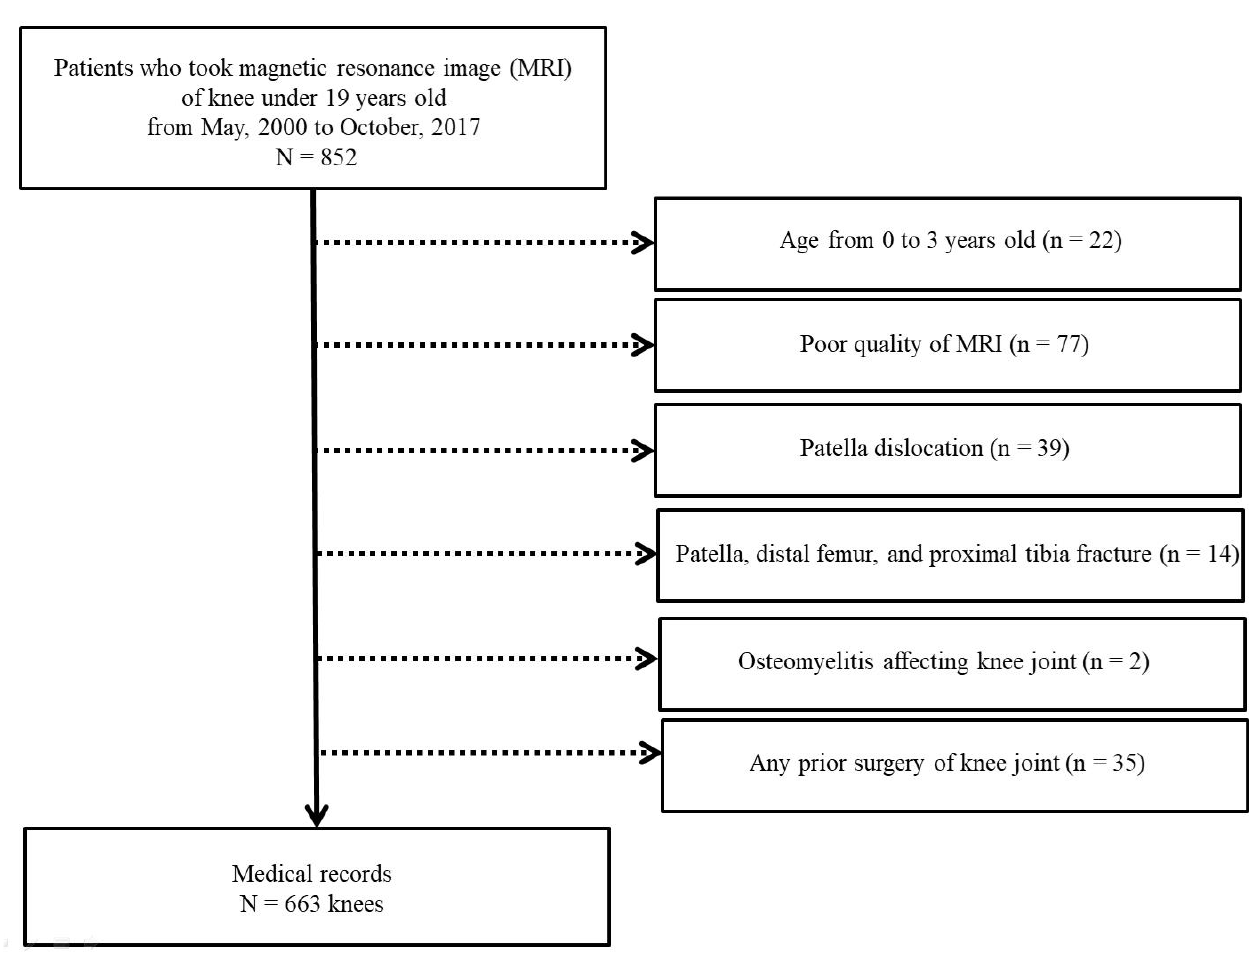
Figure 1. Flow chart showing the study population